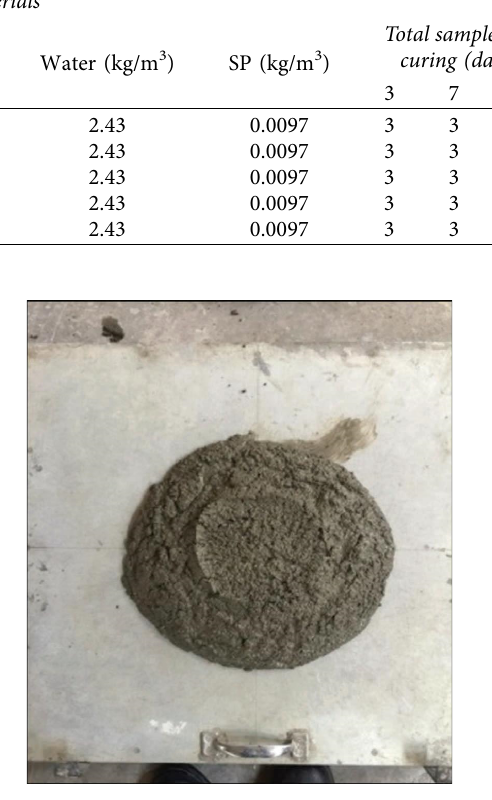
Figure 2: Slump test. Figure 3: Flow table